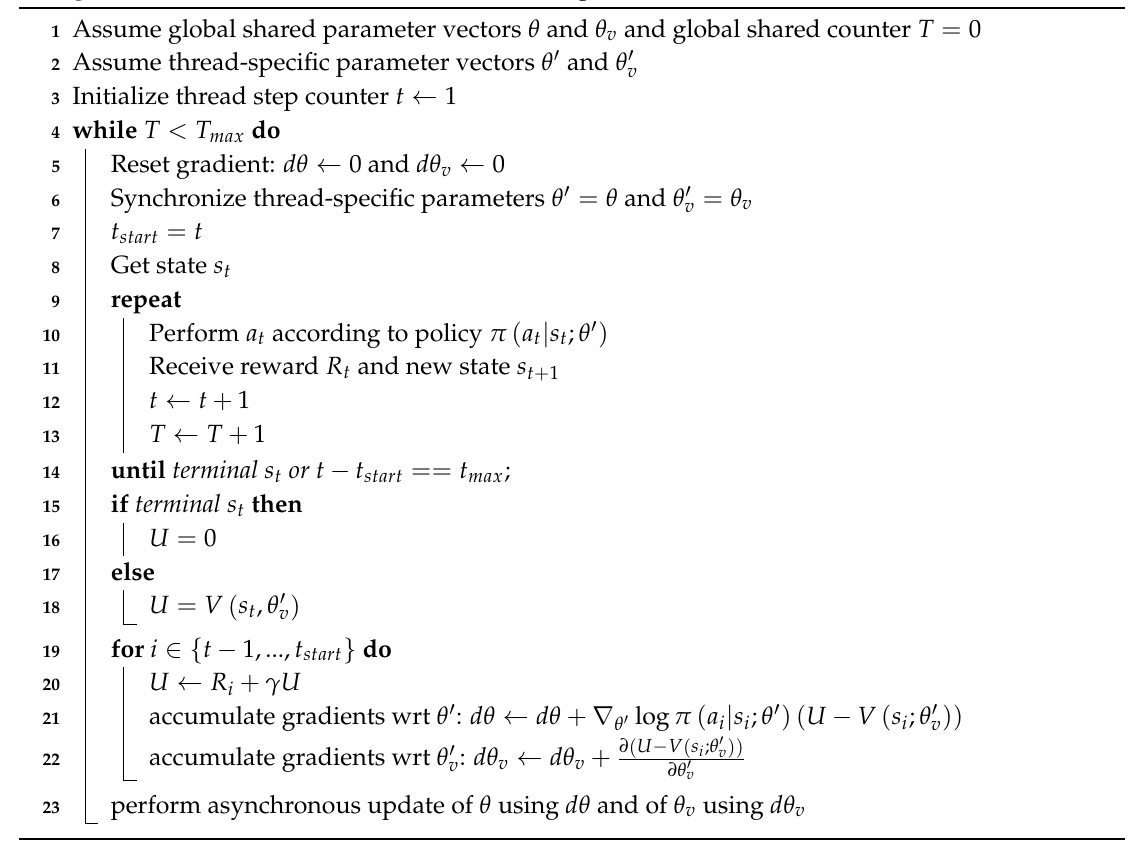
Algorithm 2: A3C-based Resource Allocation